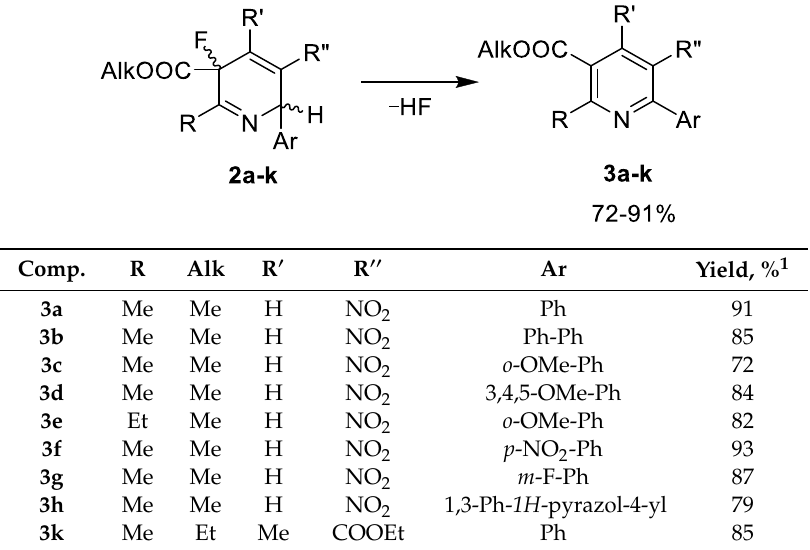
Table 2. The formation of pyridines 3a – k from 3-fluoro-3,6-dihydropyridines 2a – k after the elimination of hydrogen of hydrogen fluoride.